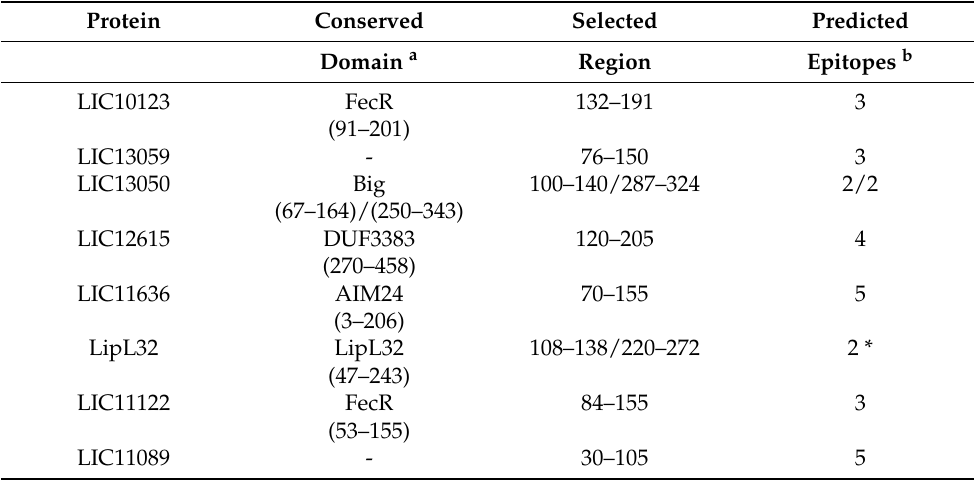
Table 1. Composition and predicted B-cell epitopes of rChi2